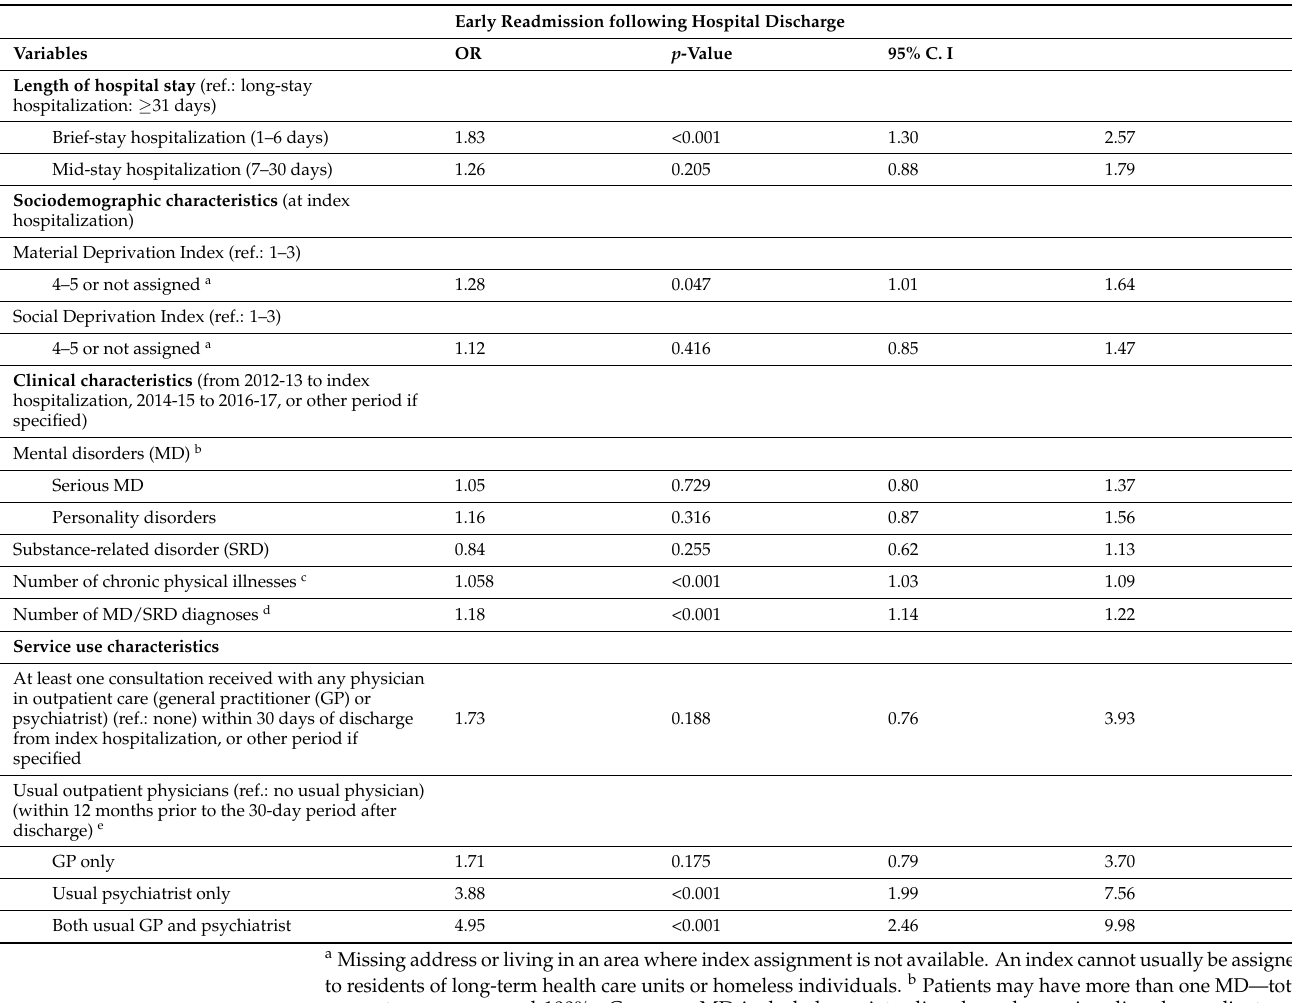
Table 4. Logistic regression model on early readmission (within 30 days) following hospital discharge from 2014-15 to 2015-16 (1 April–31 March), controlling for patient sociodemographic, clinical, and service use characteristics (reference group: no readmission within 30 days after